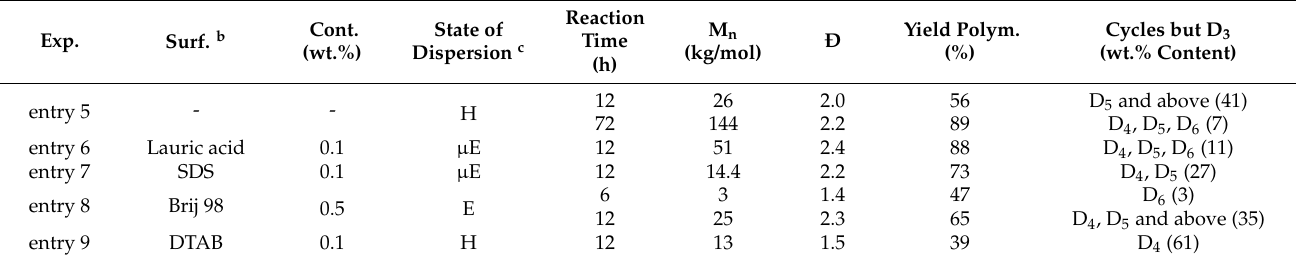
Table 2. Second round of experiments of D 3 cationic polymerization in excess water a .